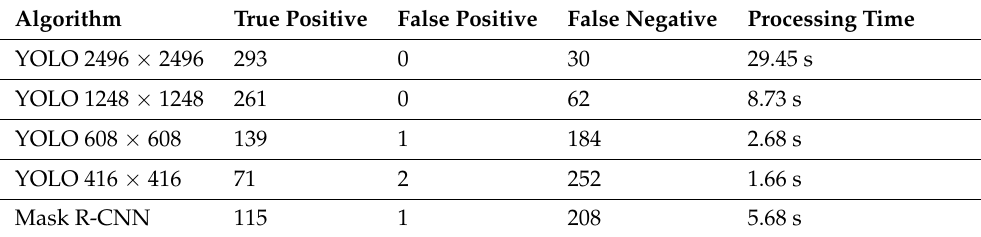
Table 2. Pedestrian detection from a low distance. Resolution 1920 × 1080. Number of pedestri- ans 323.